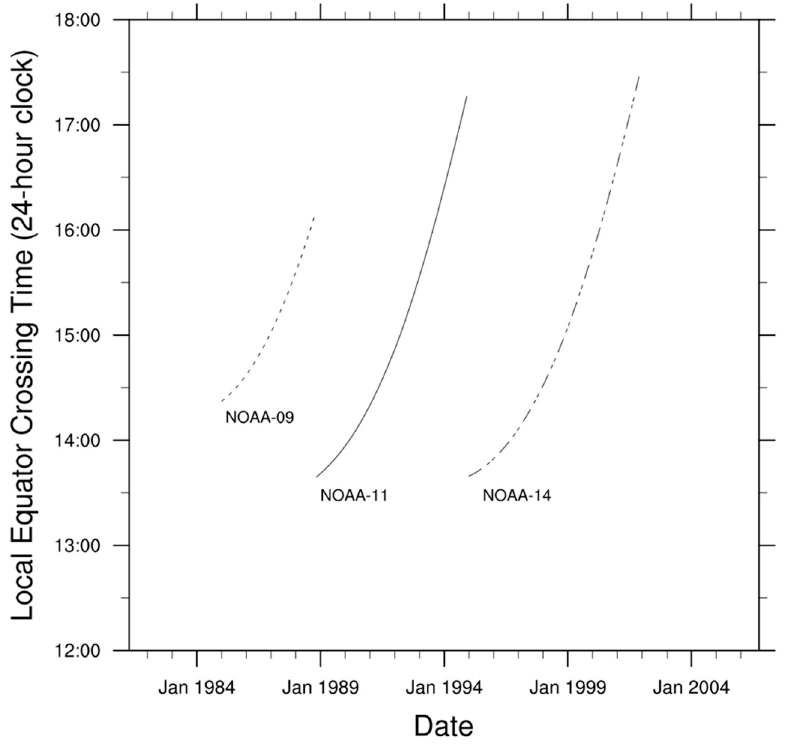
Figure 1. Evolution of orbit drift in the local equator crossing time of NOAA-09, -11, and -14 afternoon satellites between 1985 and 2001.